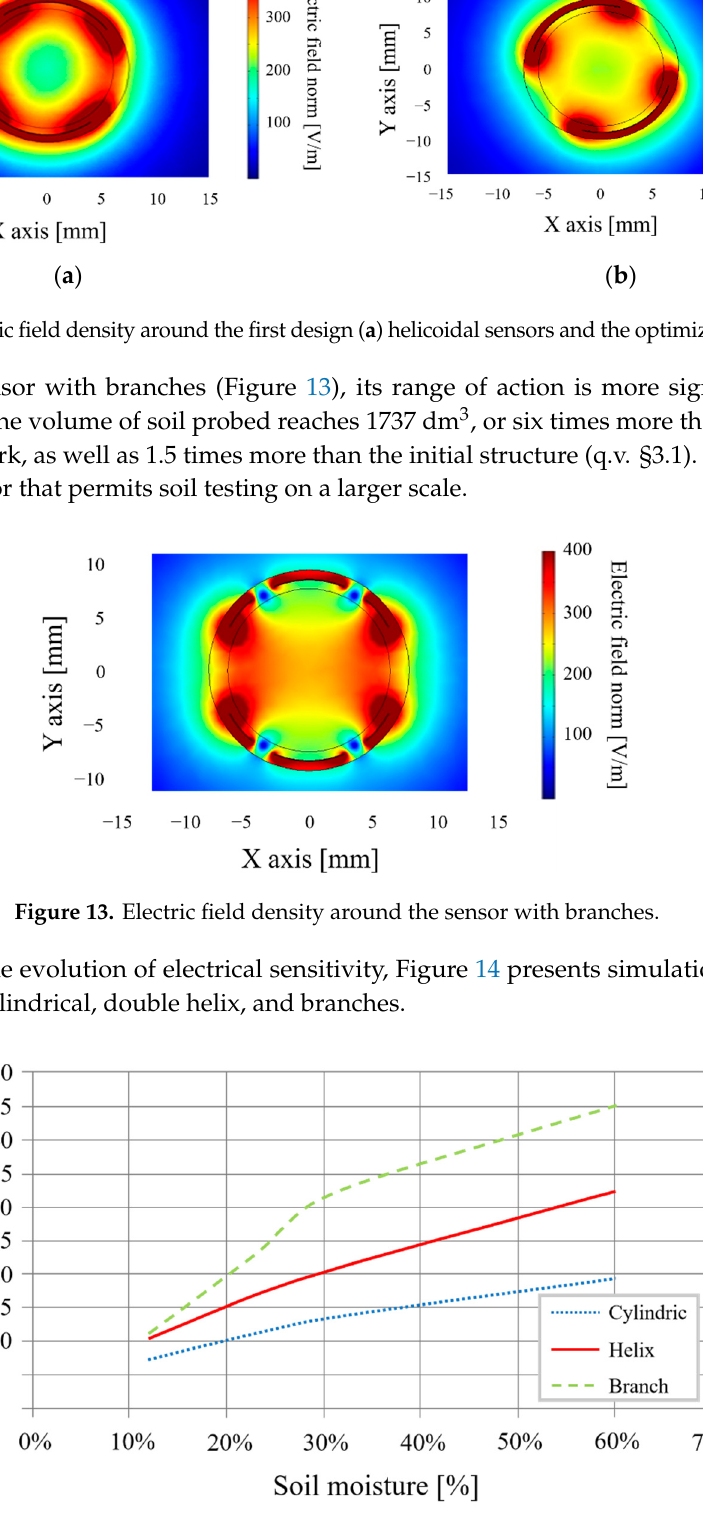
Figure 14. Different electrode shapes capacitance as a function of sensitivity to moisture.